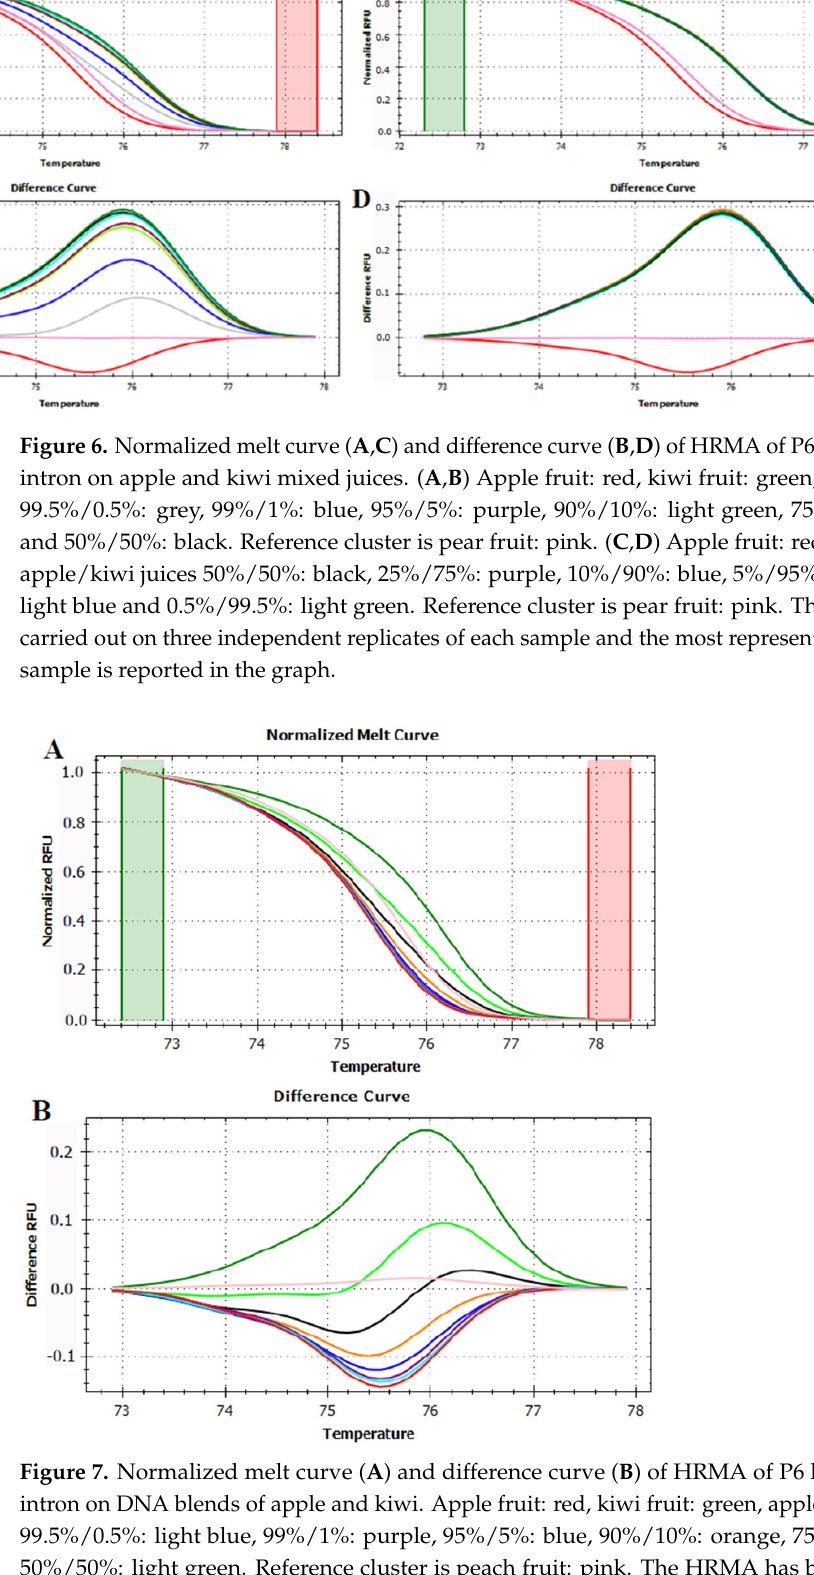
11 of 17 Figure 5. Normalized melt curves ( A ) and di ff erence curves ( B ) of HRMA of P6 loop of trnL (UAA) intron on apple and peach mixed juices. Apple fruit: red, peach fruit: blue, apple/peach juices 99.5%/0.5%: pink, 99%/1%: orange, 95%/5%: light blue, 90%/10%: violet, 75%/25%: light green and 50%/50%: black. Reference cluster kiwi fruit: green. The HRMA has been carried out on three inde- pendent replicates of each sample and the most representative curve of each sample is reported in the graph. For apple and kiwi, instead, two sets of mixed juices were produced (Table 1), one having an increasing percentage of apple juice (from 50% to 99.5%) and one having an increasing percentage of kiwi juice (from 50% to 99.5%). Juices featuring a higher percent- age of apple produced unexpected curves since they had all the same shape of kiwi fruit curve, and they did not show any negative in fl ection as the apple one did (Figure 6A,B).